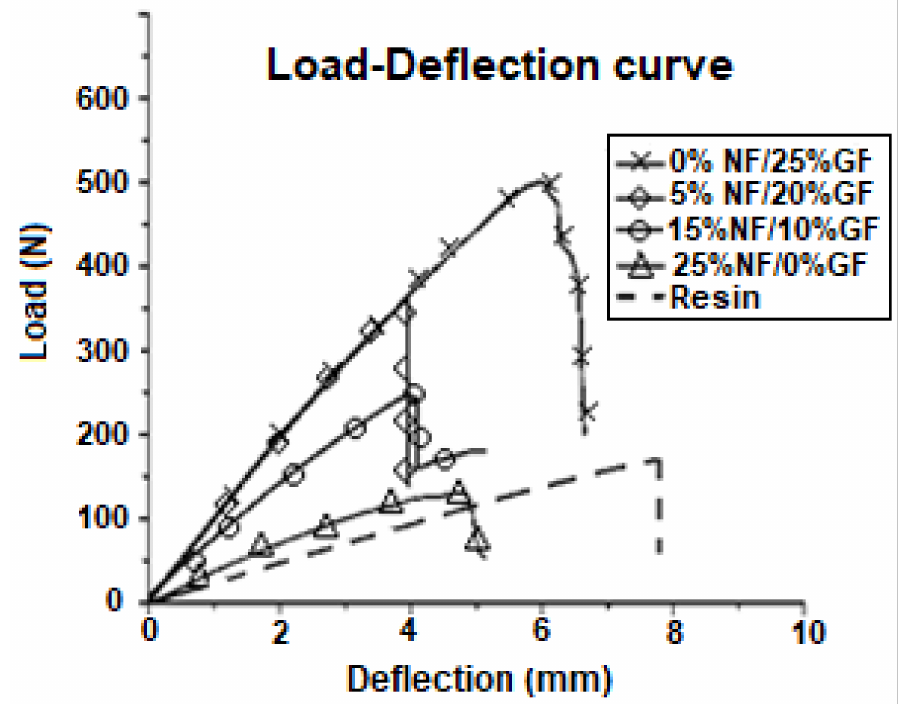
Figure 4. Load–deflection curve of the three-points bonding flexural